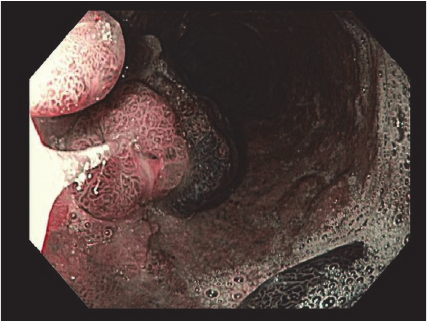
Figure 1: Patient 1. Original EGD (NBI). Several short-stalked poly- poid lesions in the esophagus.